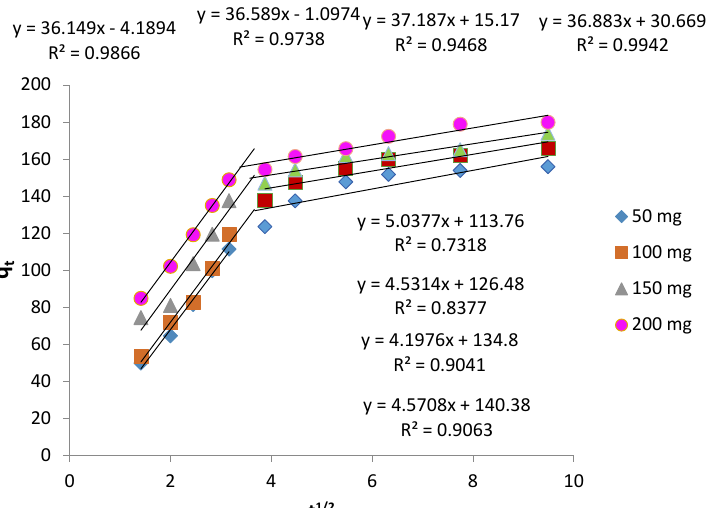
Fig. 6: Intra-particle diffusion plots for adsorption of EBT on ATPO-NPs